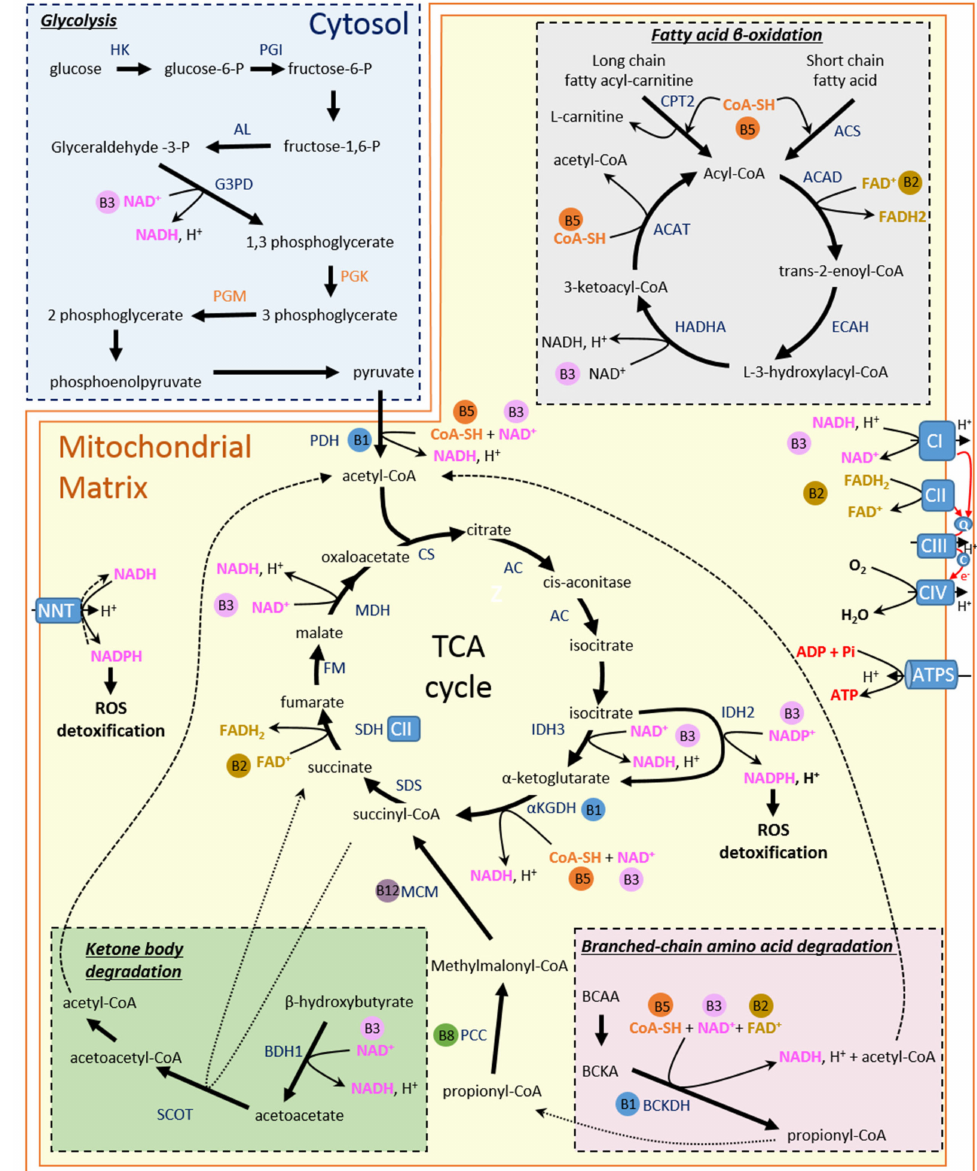
Figure 1. Role of B vitamins in energy metabolism processes in cardiomyocytes. AC, aconitase ACAD, acyl-CoA dehydrogenase; ACAT, acyl-CoA thiolase; ACS, acyl CoA synthetase; AL, aldolase; BCAA, branched-chain amino acid; BCAT, branched-chain amino acid transaminase; BCKA, branched-chain keto acids; BCKDH, branched-chain keto acid dehydrogenase; BDH1, beta-hydroxybutyrate dehydro- genase; CPT2, carnitine O-palmitoyltransferase 2; CoA-SH, Coenzyme A; CS, citrate synthase; ECAH, Enoyl-CoA hydratase; EL, enolase; FAD = , flavin adenine nucleotide; FADH 2 , reduced form of FAD + ; G3PD, glyceraldehyde-3-phosphate dehydrogenase; FM, fumarase, HADHA, L-3-hydroxyacyl-CoA dehydrogenase; HK, hexokinase; IDH, isocitrate dehydrogenase; α KGDH, alpha-ketoglutarate dehy- drogenase; MCM, methylmalonyl-CoA mutase; MDH, malate dehydrogenase, NAD + , nicotinamide adenine dinucleotide; NADH, reduced form of NAD + ; PCC, propionyl-CoA carboxylase; PDH, pyruvate dehydrogenase; PGI, phosphoglucose isomerase; PGK, phosphoglycerate kinase; PGM, phosphoglycerate mutase; PK, pyruvate kinase; SCOT, succinyl-CoA:3 oxoacid-CoA transferase SDH, succinate dehydrogenase; SDS, succinyl-CoA synthase; TCA, tricarboxylic